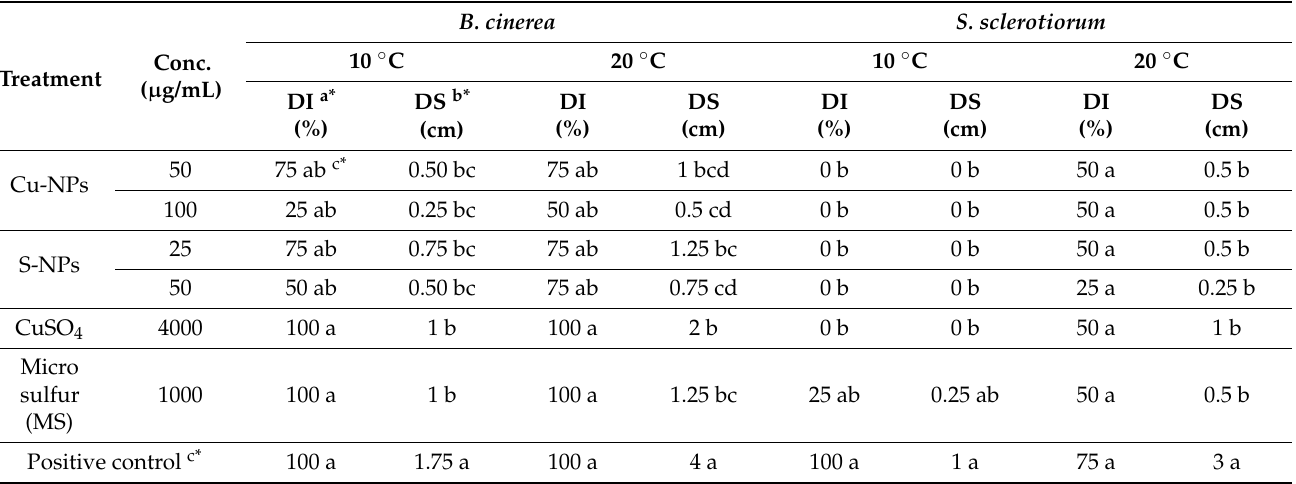
Table 2. Effect of Cu-NPs and S-NPs at different concentrations on disease incidence (DI) and disease severity (DS) caused by B. cinerea and S. sclerotiorum on cucumber fruits incubated at two temperature levels (10 and 20 ◦ C). a* DI was calculated six days after inoculation according to the following